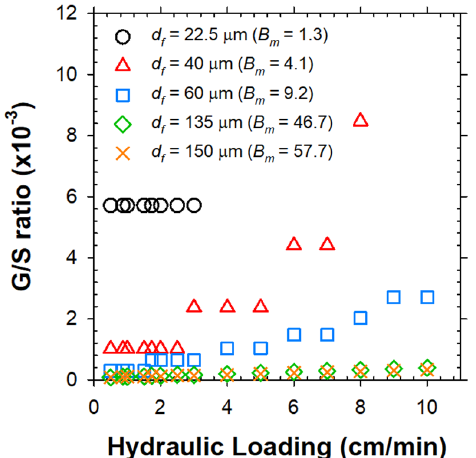
Figure 5. Relations of ( a ) V bf versus B n and ( b ) minimum B n versus v for individual bio-particles with variable sizes.